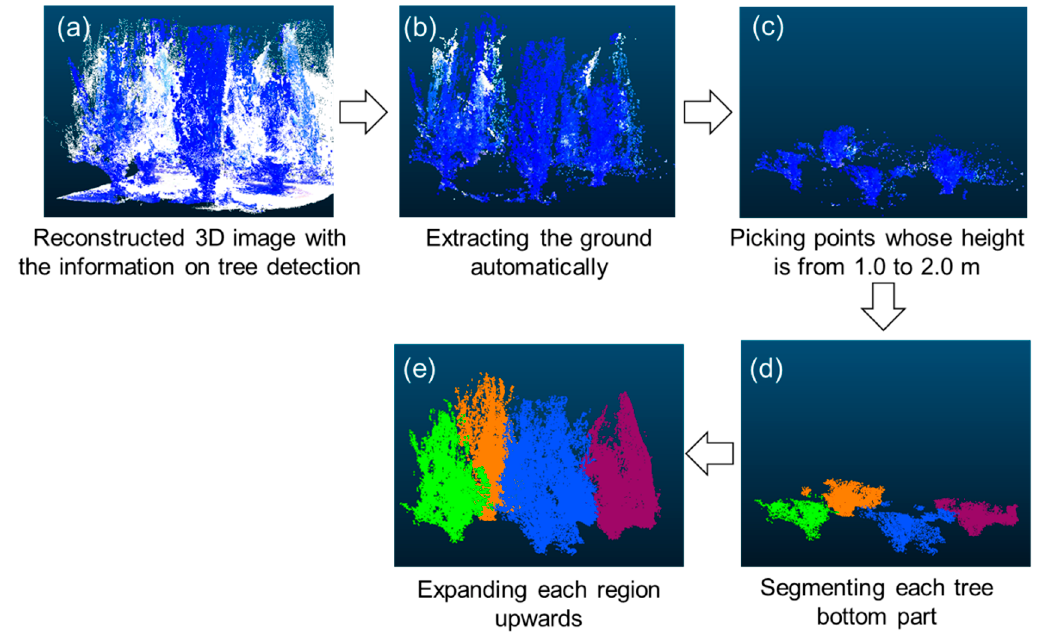
Figure 9. Overview of the post-processing of 3D images reconstructed using Structure from Motion (SfM). This method referred to previous methods [47,48]. Panel ( a ) shows the reconstructed 3D image with the information of “tree”, as predicted by the YOLO v2 detector. The point indicated by blue corresponds to the tree point. Then, the ground was automatically reduced using the Maximum Likelihood Estimation Sample and Consensus (MLESAC) algorithm [49] as shown in the panel (b). Next, the points with the heights of 1.0–2.0 m were extracted ( c ). Then, the points within 30 cm were clustered into the same group ( d ). Finally, each tree could be segmented after expanding each region into the upper direction ( e ).